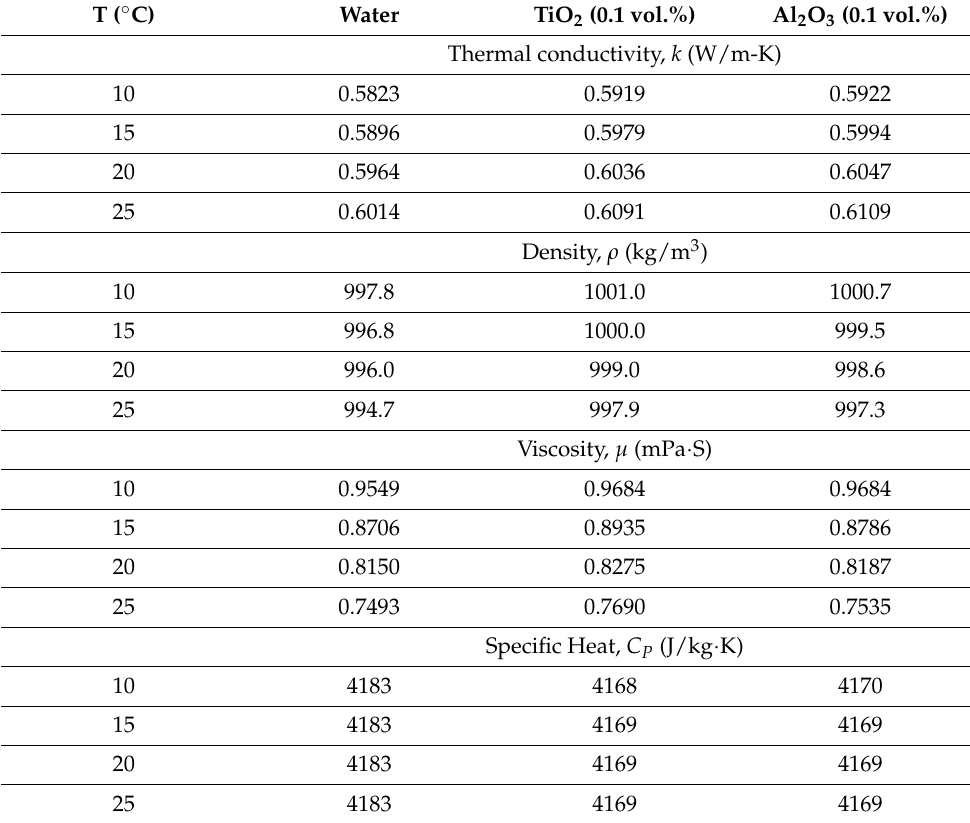
Table 5. Experimental data for thermo-physical properties of different fluids.